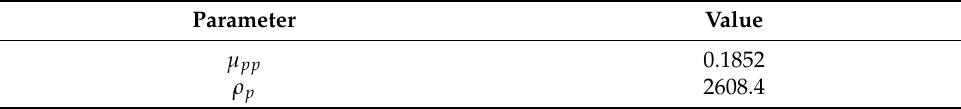
Table 5. Optimal parameter set identified by MBGC.